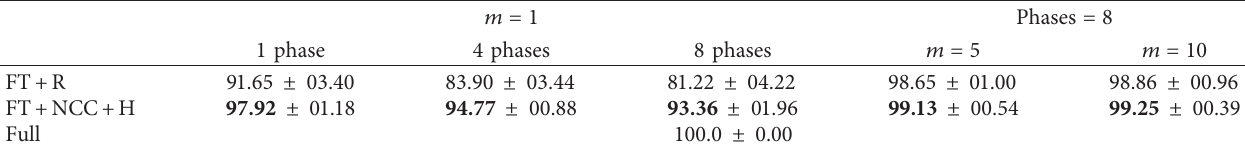
Table 6: Average accuracy and standard deviation (SD) for MCIL methods over CWRU, using a different number of incremental phases of